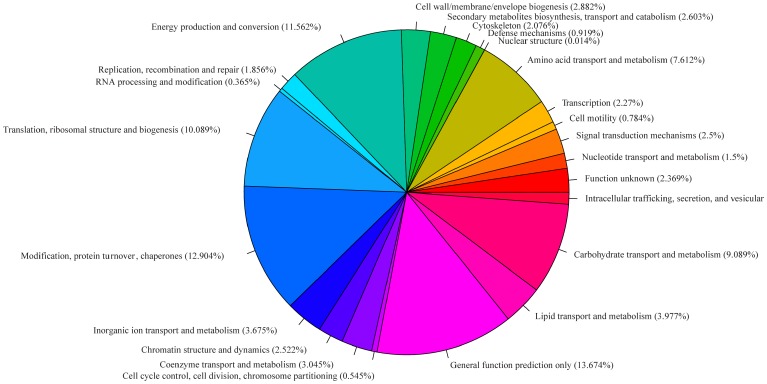
Paragraph, COG annotation and categorization of all unigenes.The unigenes were classified into different functional groups based on COG annotation.